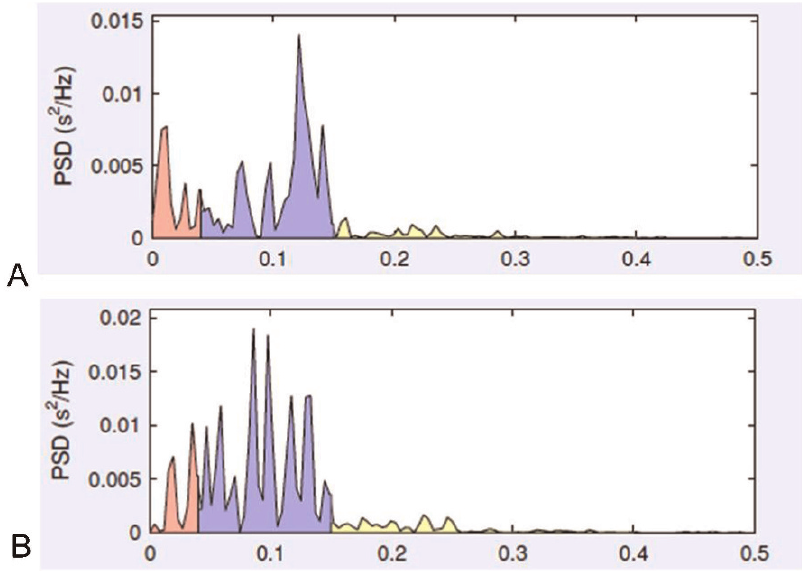
Figure 3 - Power spectral density analysis observed in one subject at 5-10 minutes after exercise (A) and 25-30 minutes after the flexible pole protocol